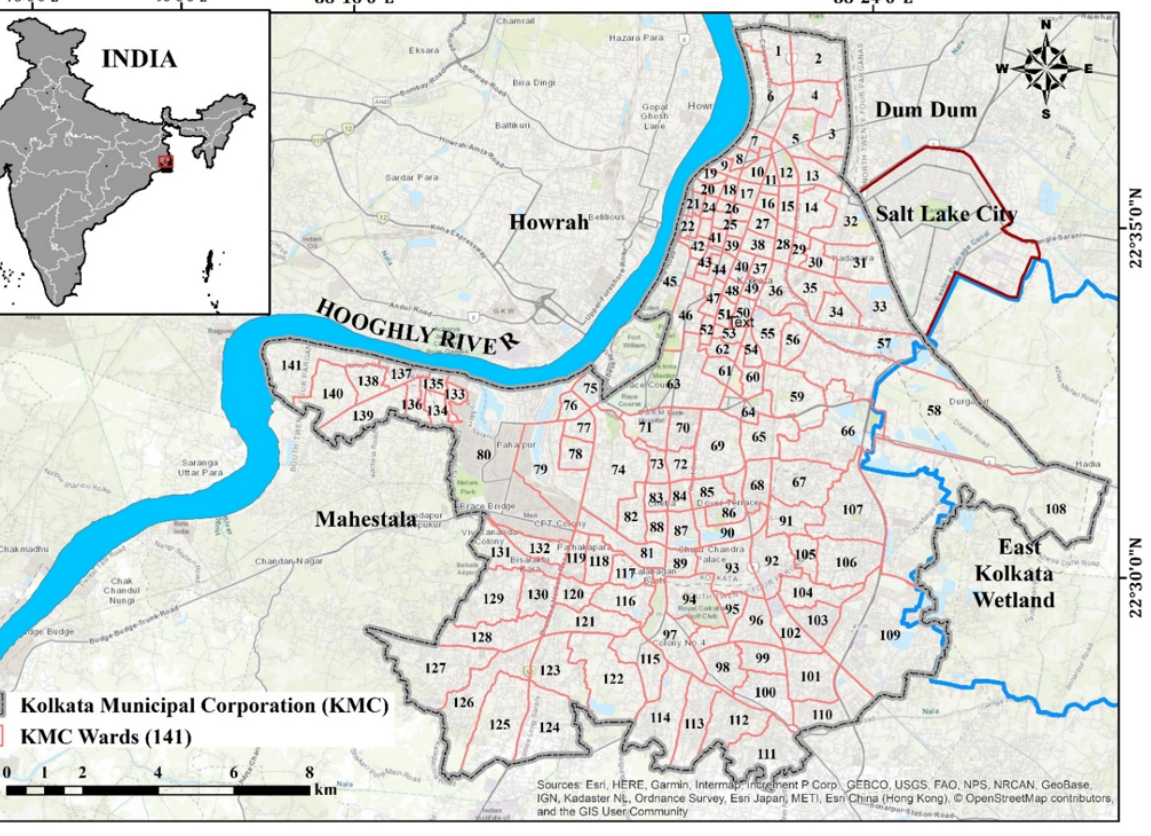
Figure 1. Location of the study